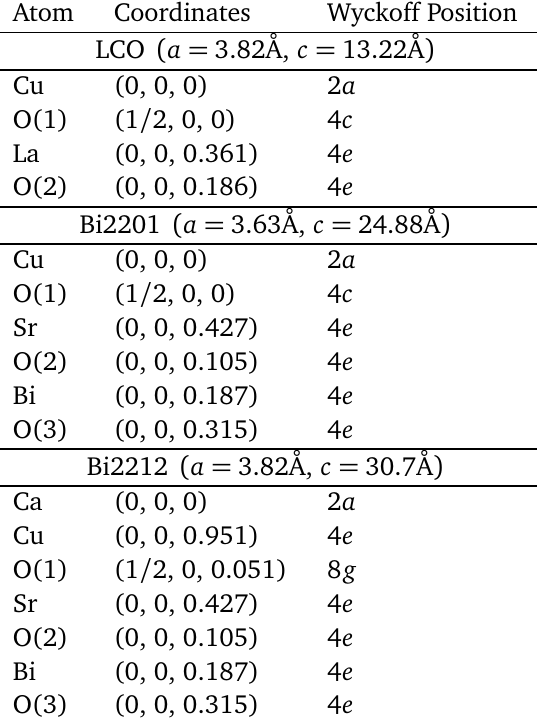
Table 1: Wyckoff positions in the I 4 / mmm unit cell for La Bi Sr CaCu 2 2